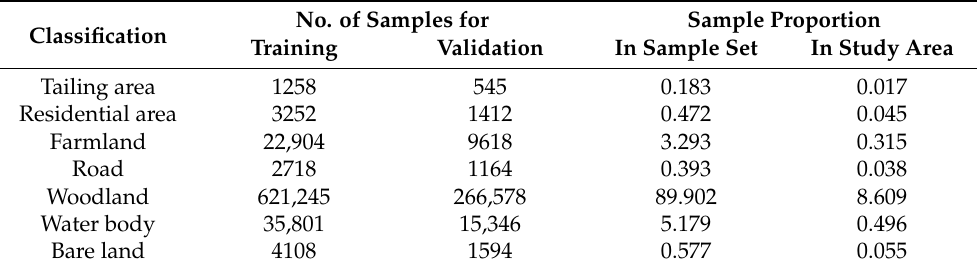
Figure 5. Ground truth datasets for land cover mapping: ( a ) training set and ( b ) validation set. Table 3. Ground truth sample composition for land cover